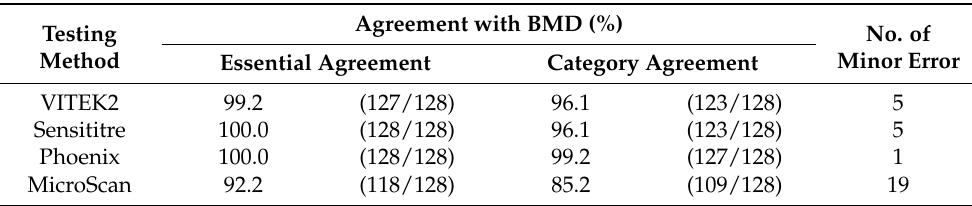
Table 2. Agreements of vancomycin susceptibility results between different antimicrobial susceptibil- ity testing methods and broth microdilution